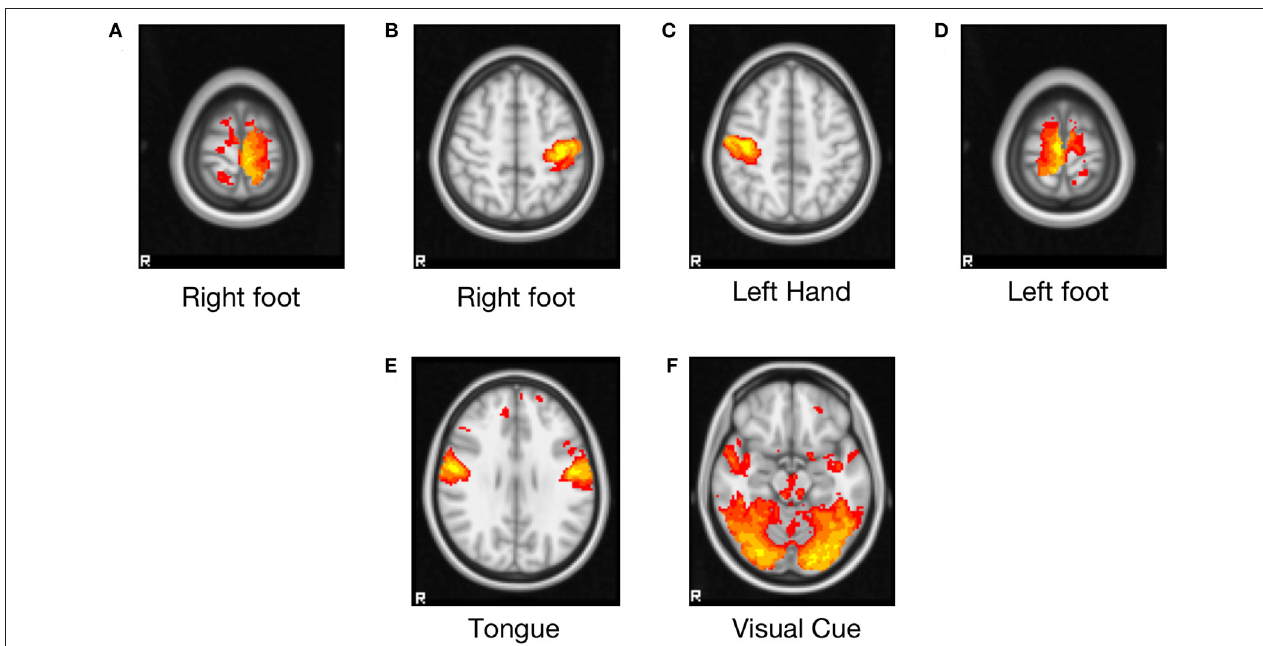
FIGURE 2 | Group-level clusters of each task block from 50 randomly selected subjects of the HCP motor task-fMRI dataset. Z statistic images were thresholded using clusters determined by Z > 3.1 at a cluster significance threshold of P = 0.05 (corrected). FEAT (FMRI Expert Analysis Tool, v6.00) was used for the analysis. The General Linear Model was used to model six blocks (five task blocks, one cue block). Task blocks consisted of tapping left or right fingers, squeezing left or right toes, or moving the tongue, preceded by a visual cue block. The brain areas covered by these clusters are listed in Table 2 . (A) Right foot, (B) right hand, (C) left hand, (D) left foot, (E) tongue, (F) visual cue.